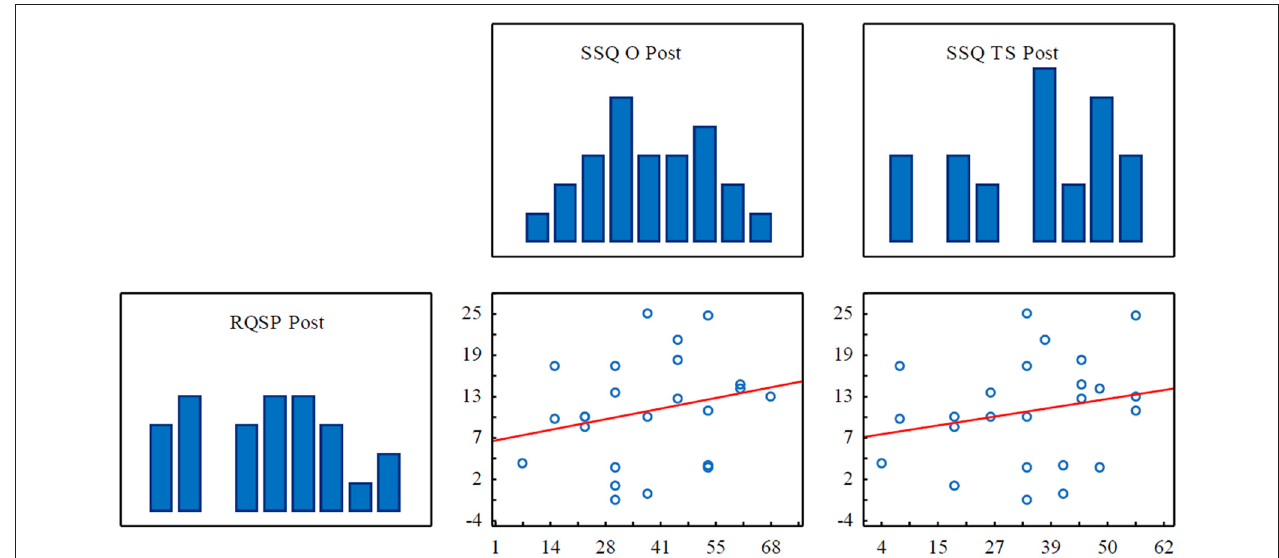
FIGURE 5 | Scatterplots and histograms for Spearman’s rank correlation showing the relationships between RQSP (Romberg quotients for sway path) and the SSQ oculomotor subscale scores as well as the SSQ total